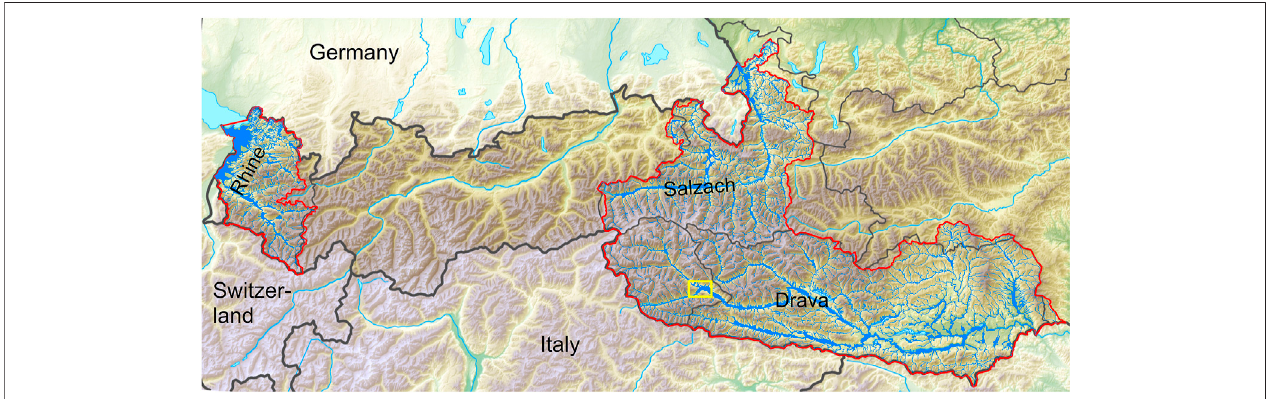
FIGURE 4 | Spatial distribution of the fl uvial corridors at approximately 300-year fl oods between 1826 and 1859 (blue) within the study area (red; yellow rectangle: see detail in Figure 5 ).